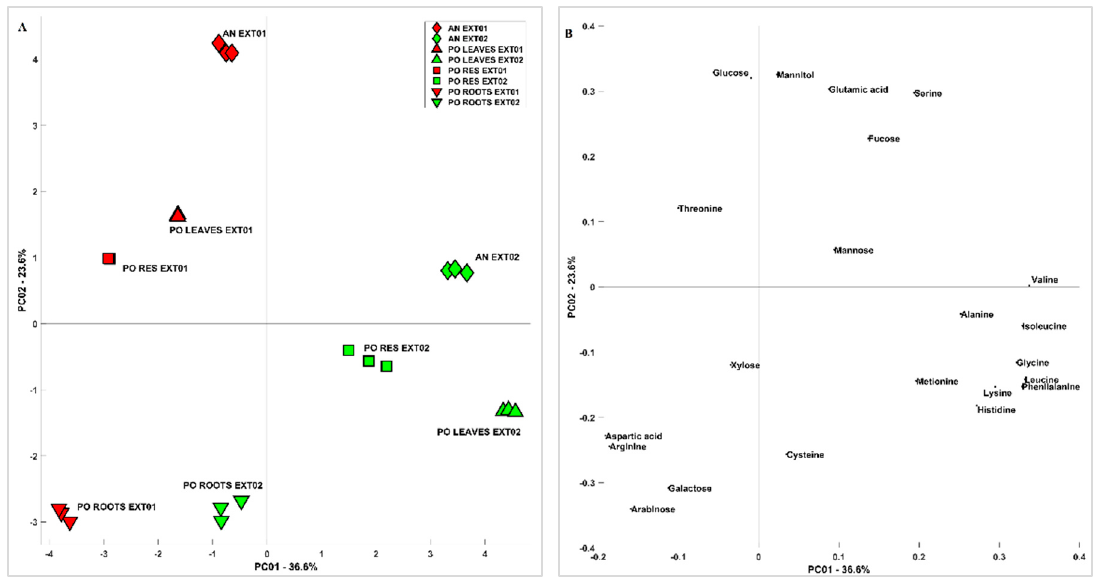
Figure 1. The PCA of the carbohydrate and aminoacidic content of Posidonia oceanica and Ascophyllum nodosum Extracts 1 and 2. ( A ) Scores and ( B ) loadings of PC1 vs. PC2.